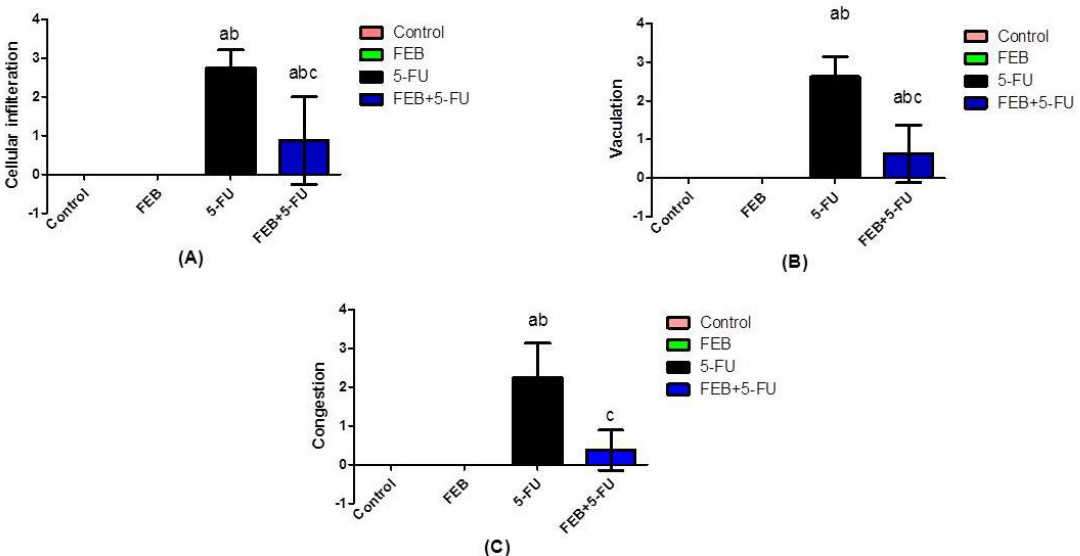
Figure 5. Scores of the histological findings. Values were expressed as the mean ± S.D. ( A ) shows the cellular infiltration score. ( B ) shows the vacuolation score. ( C ) shows the congestion score. Results were considered significantly different when p < 0.05. a Significant difference relative to the control, b significant difference relative to the FEB group, and c significant difference relative to the 5-FU group. (5-FU: 5-fluorouracil and FEB: febuxostat; 8 rats/group).